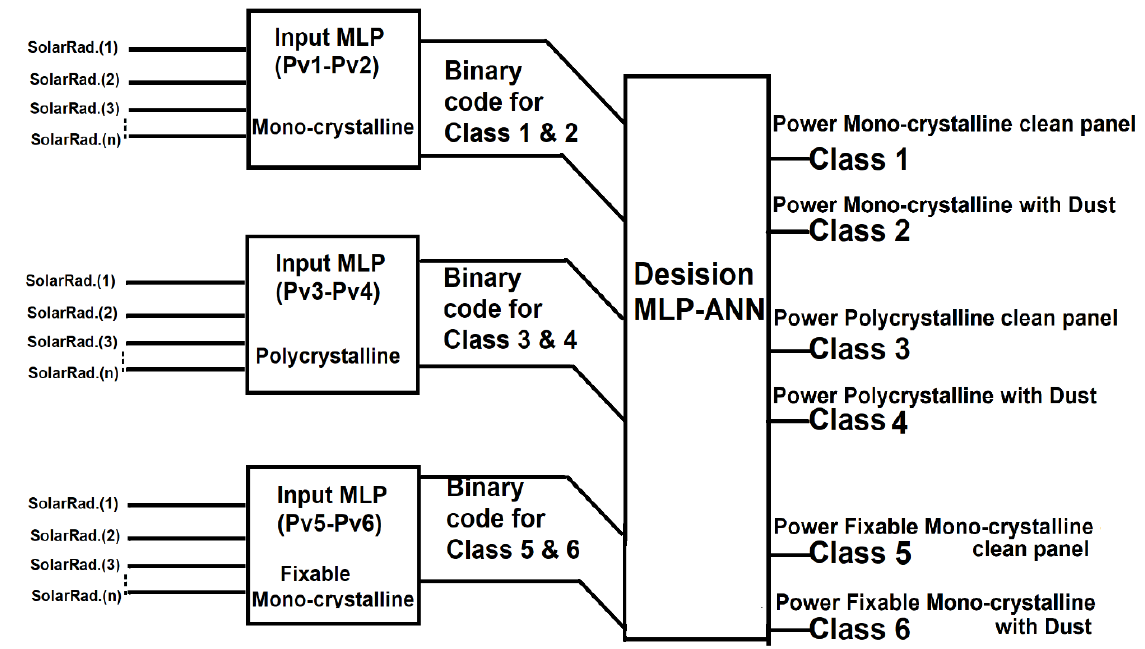
Figure 5. Proposed Modular Neural Network Architecture.